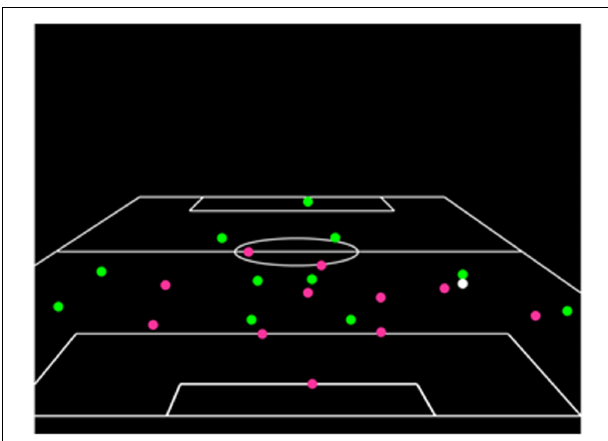
FIGURE 1 | A schematic illustration of the information presented during the viewing phase.